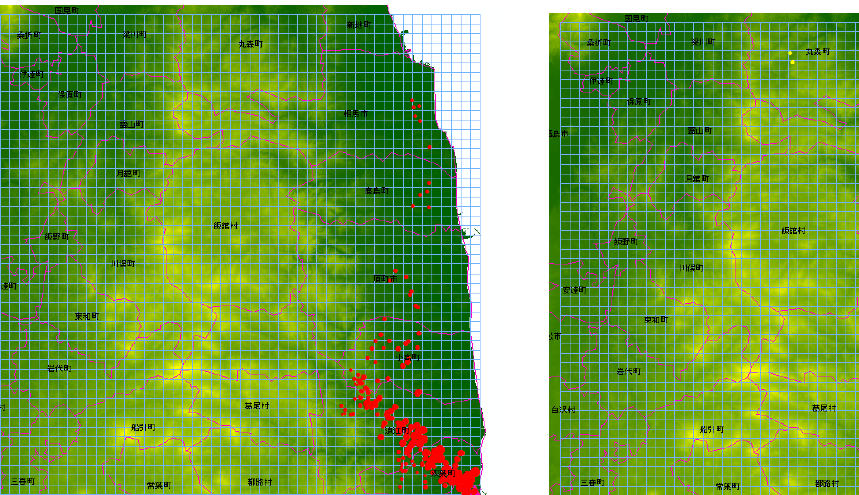
Figure 11. Particle trajectory estimated from wind directions and velocities on March 20